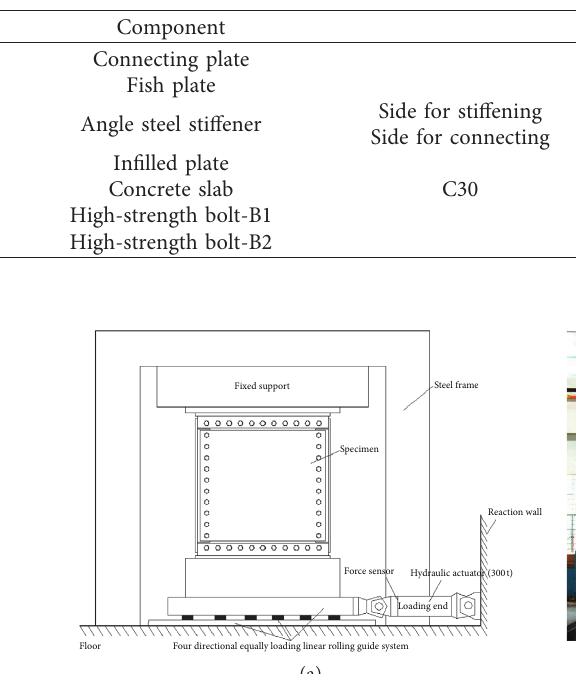
Table 5: Components of BRSPSW specimen.